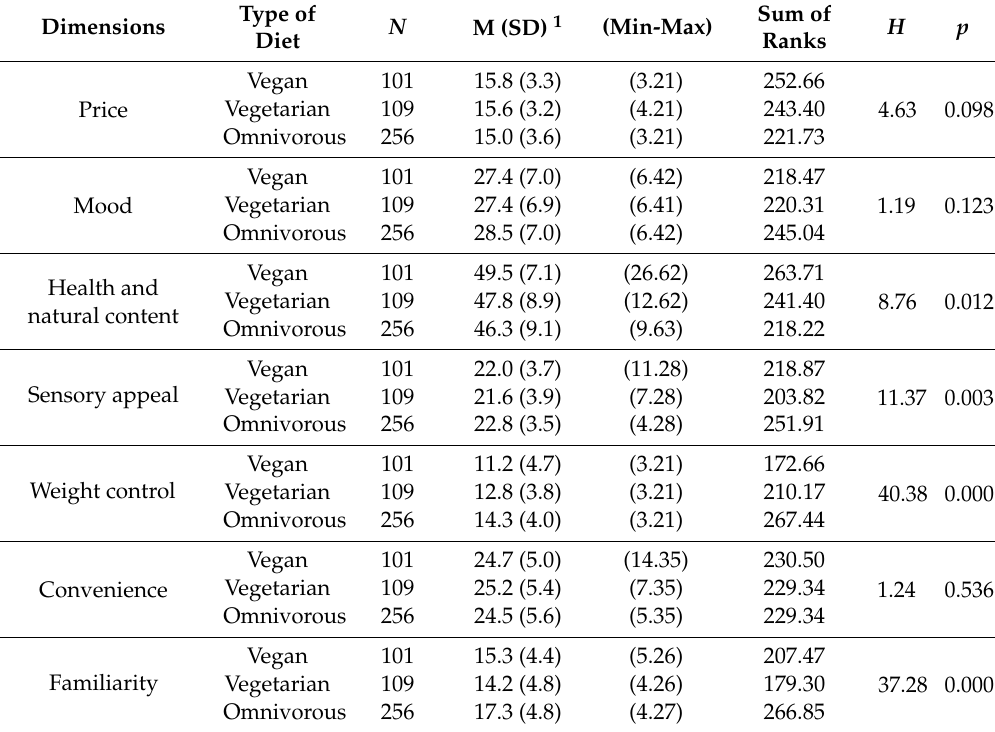
Table 2. The distribution of the Food Choice Questionnaire (FCQ-SP) Spanish version scores of the vegans, vegetarians, and omnivores according to Kruskal–Wallis H